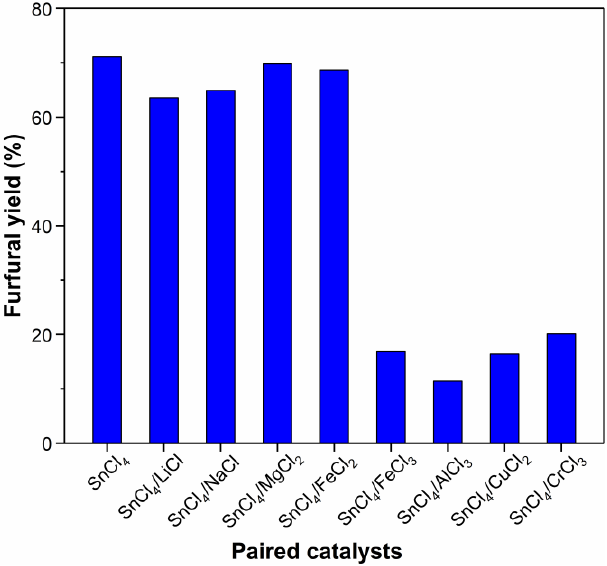
Figure 3. Effect of different paired catalysts on the dehydration of xylose into furfural. Reaction conditions: 200 mg xylose, 1000 mg of EMIMBr; molar ratio of catalyst:xylose = 1:10, SnCl 4 and another metal chloride molar ratio 4:1; 130 °C; 1 h. Table 1. Effect of different dosage of SnCl 4 and MgCl 2 on the dehydration of xylose into furfural.